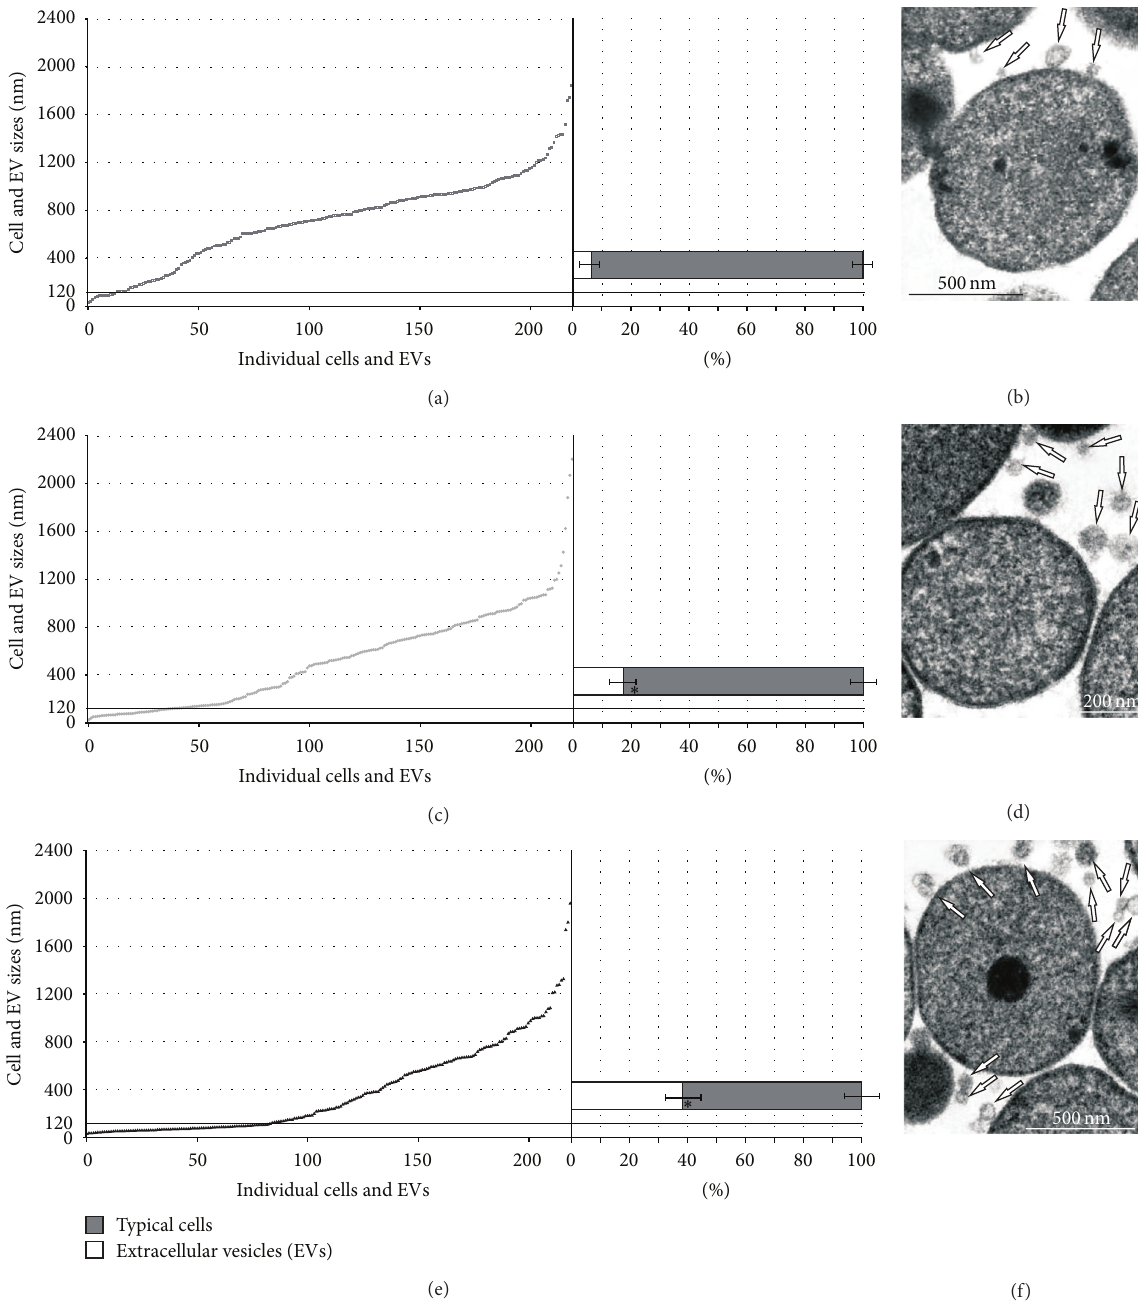
of some bacteria may allow the traffic of genes that encode antibiotic-targeted proteins, thereby mediating the horizontal transfer of nucleotide sequences that determine antibiotic resistance in bacterial populations [31,